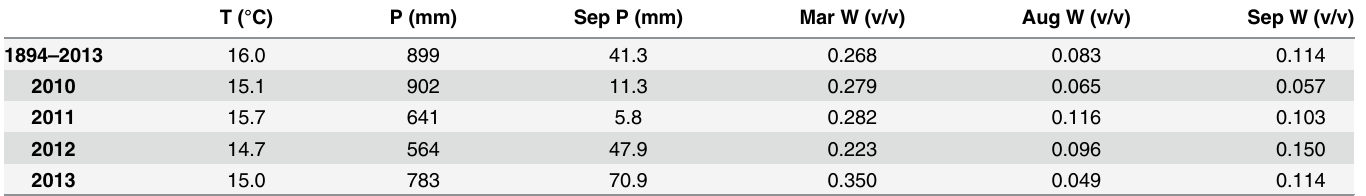
Table 1. Mean temperature (T), annual precipitation (P), precipitation in September (Sep P) and soil moisture in March (Mar W), August (Aug W) and September (Sep W) for the long-term mean and for each studied year. T (°C) P